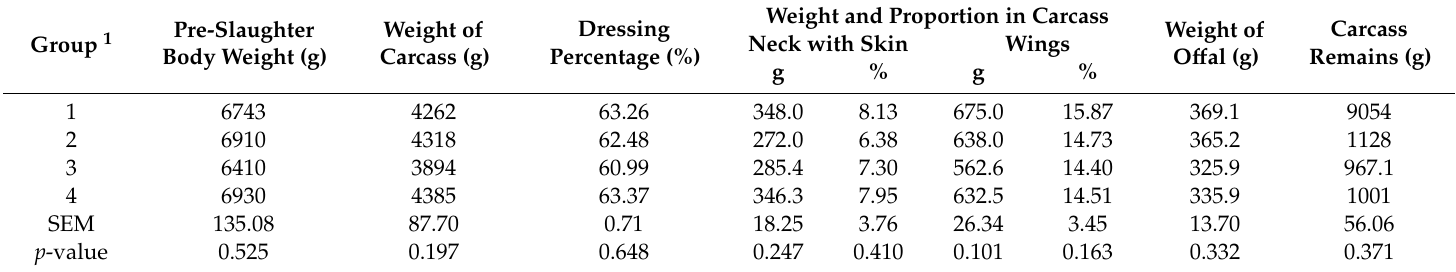
Table 5. Meat traits of 77-day-old broiler geese *.